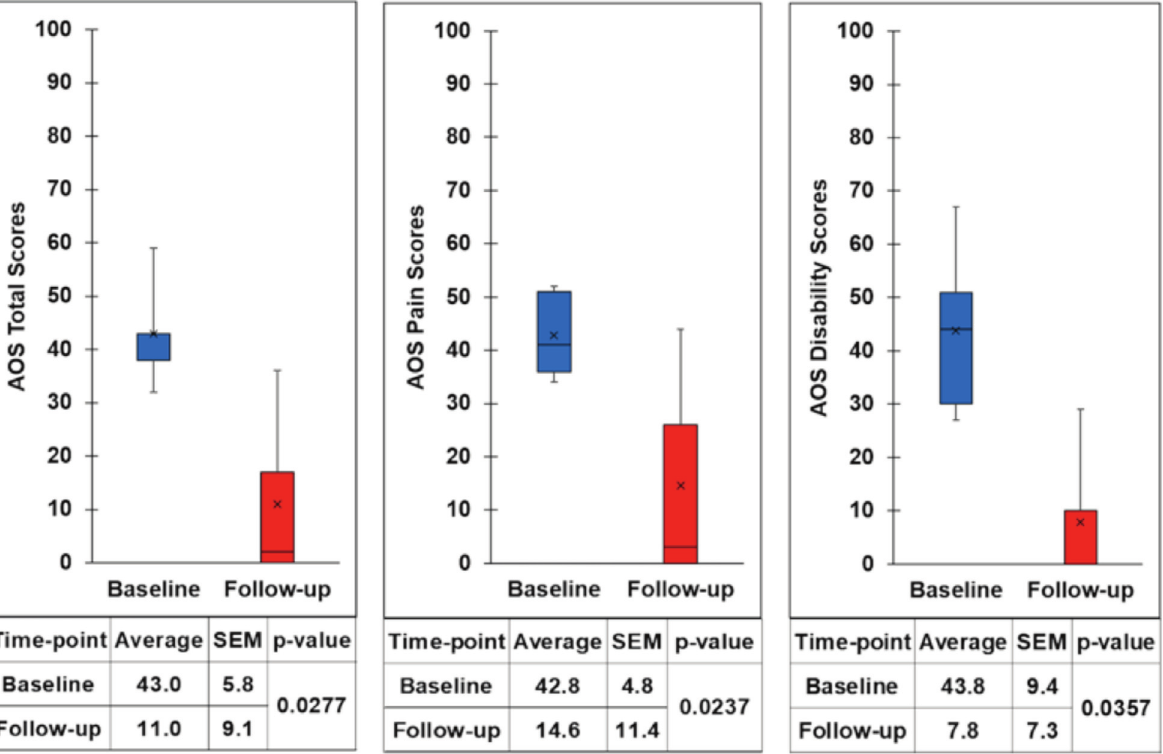
Fig. 3: Box plot showing clinical outcome measure scores, pre-operatively and at the time of the latest follow-up for the five cases, with a minimum two years follow-up. The top and bottom of the box represent the interquartile range, the line within the box represents the median, the ‘x’ within the box represents the mean and the whiskers indicate the range. Ankle Osteoarthritis Scale (AOS) scores show greater pain and disability when the number is higher. Improvement of pain and disability (p < 0.05) is indicated by lower numbers at follow-up. SEM = Standard Error